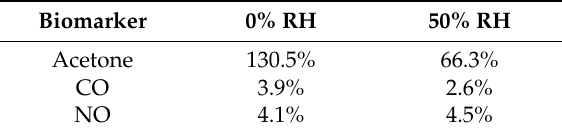
Table 4. Percentage variation between the maximum concentration in a healthy person and the minimum in a sick person, both at 0% RH and 50% RH.